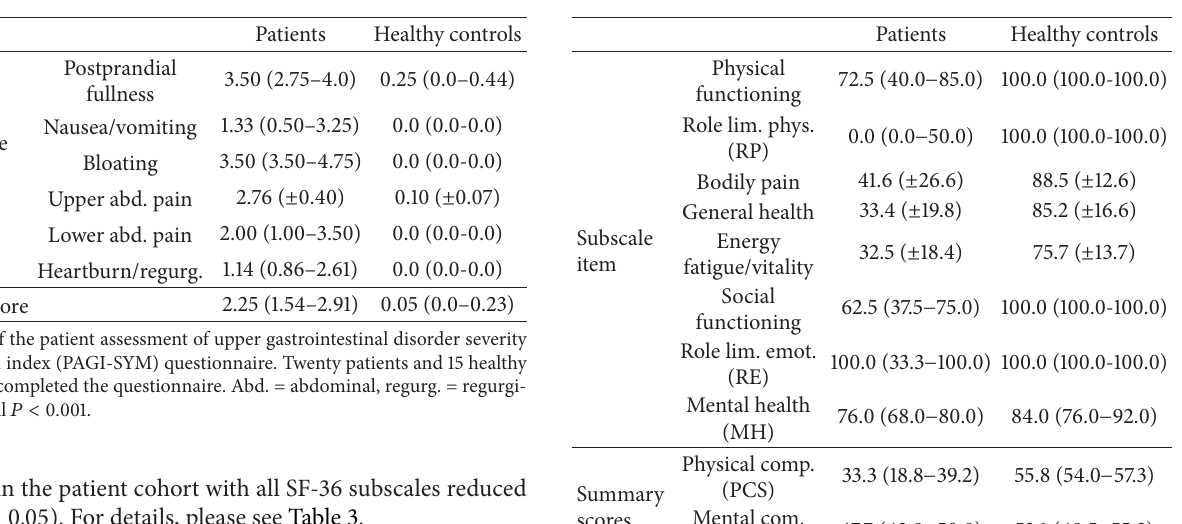
Table 2: PAGI-SYM scores. Table 3: SF-36